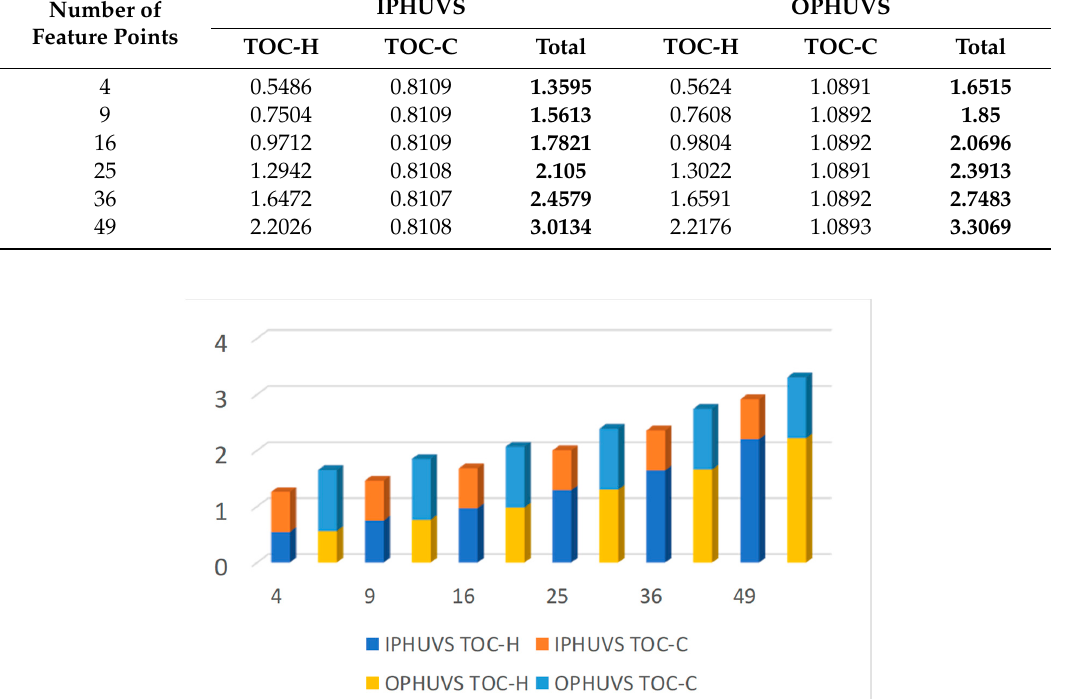
Table 4. Detailed value of the TOC of the original PHUVS and improved PHUVS.